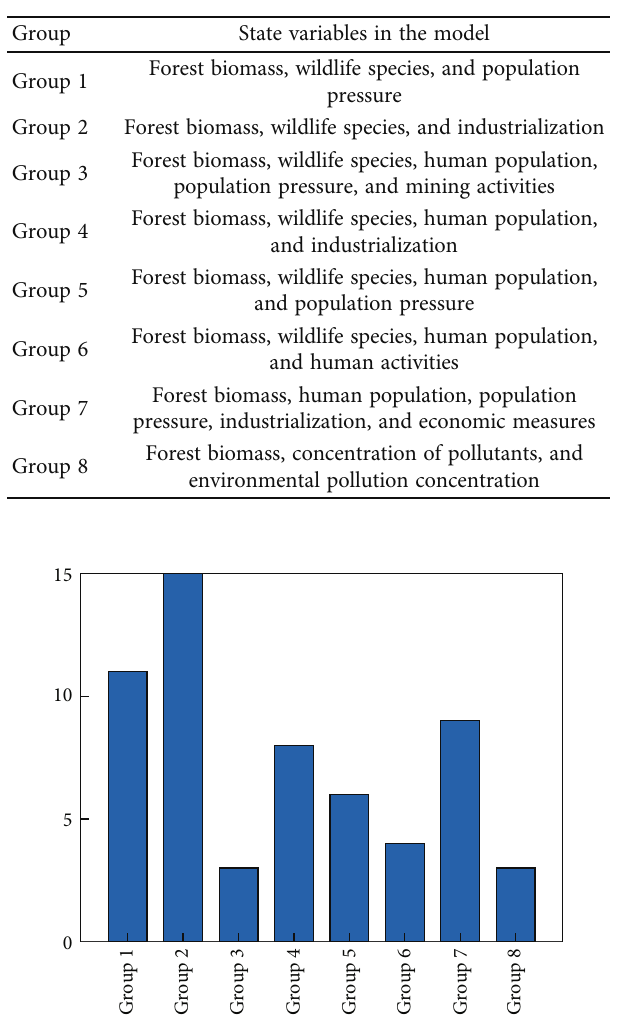
Table 1: Groups of relevant articles based on the state variables used in modelling process.